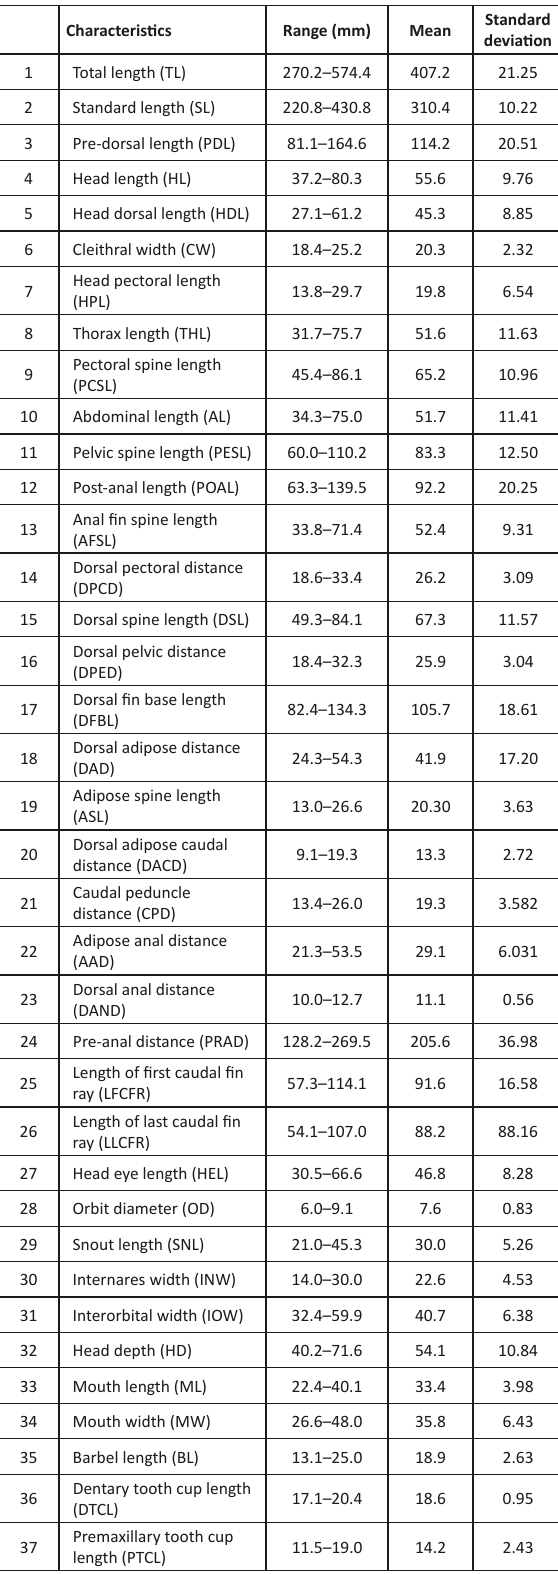
Table 1. Meristic characteristics of Pterygoplichthys disjunctivus and P.